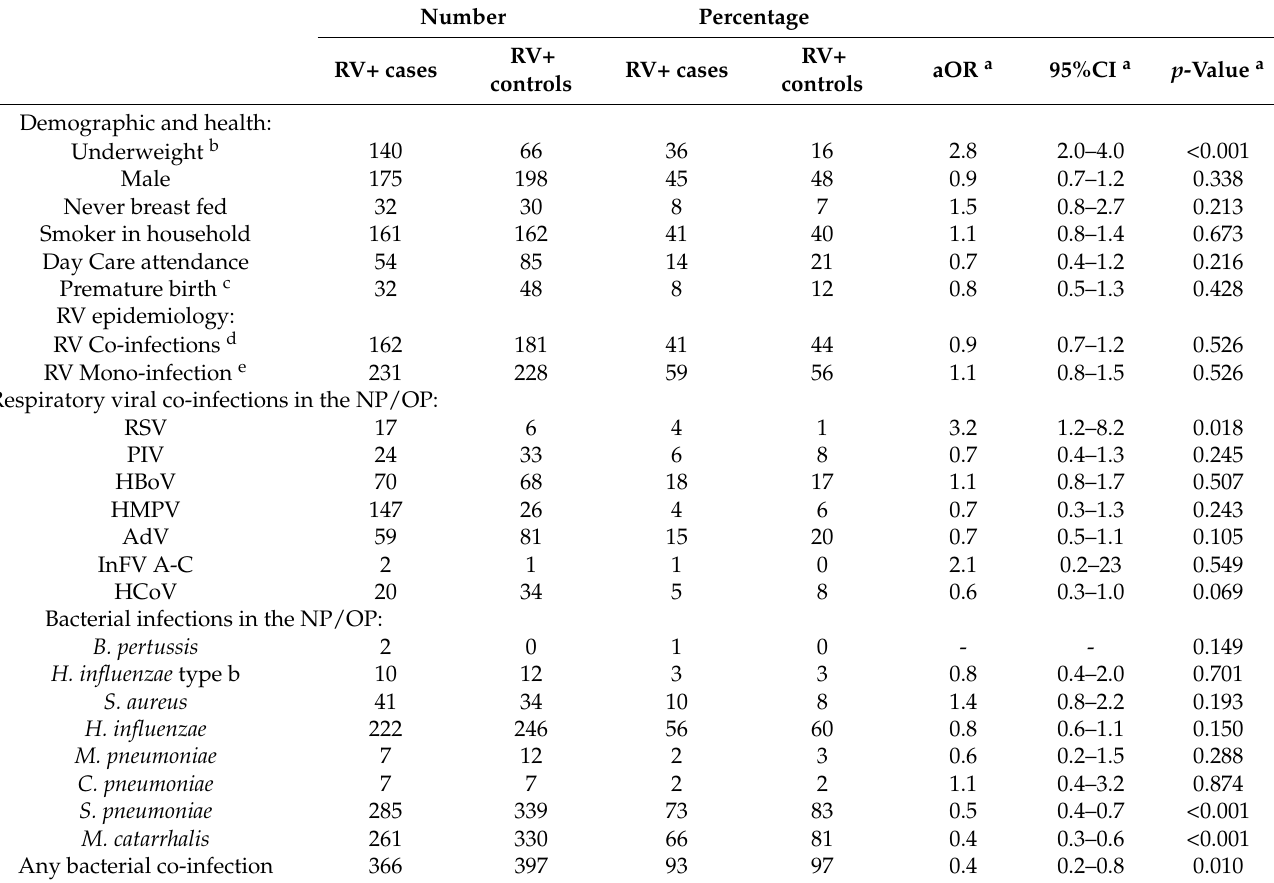
Table 5. Demographic, Clinical, and Laboratory Findings of 12- to 59-month-old rhinovirus-Positive Pneumonia Cases ( N = 393) and Controls ( N = 409), All PERCH